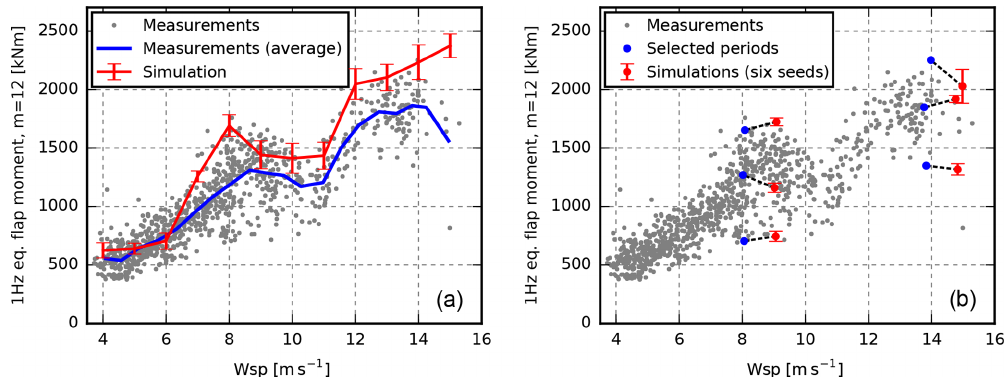
Figure 1. Two approaches for comparing the measured and simulated loads. (a) The traditional approach where the site-average turbulence characteristics and shear profile are used as input for the aeroelastic simulations. The results are compared to the measured average load levels. (b) The suggested one-to-one approach where measured inflow characteristics are extracted from selected time series. The simulation results are compared to the corresponding measurement observation. Note that the simulation error bars are offset 1ms − 1 to the right to increase clarity.